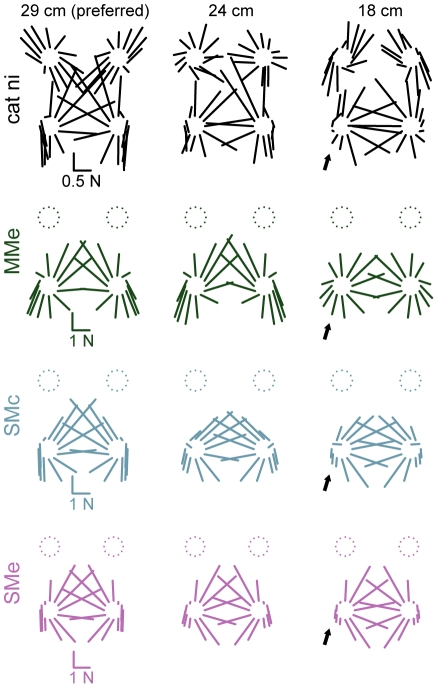
Predicted horizontal plane forces obtained by controlling experimentally-derived muscle synergies versus individual muscles.Top to bottom: average horizontal-plane forces observed in each postural configuration of cat ni (black), predictions of models controlling individual muscles: MMe (green), or muscle synergies: SMc (blue), and SMe (purple). Arrows highlight significant force magnitude reductions observed in data, SMc, and SMe, but not in MMe.